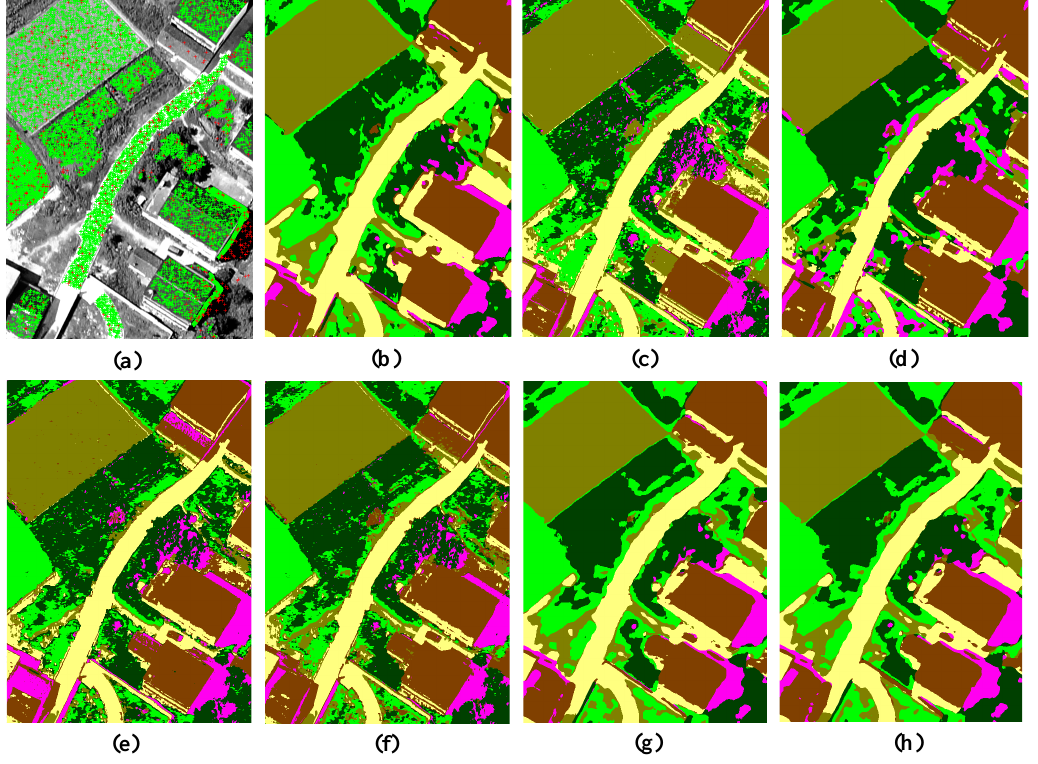
Figure 11. Classification results of the compared methods for JX_1 data: ( a ) Selected training samples (red markers are the initial selected training points, and the green markers are the final selected training points). ( b ) CNNs. ( c ) TSVM. ( d ) SemiMLR. ( e ) SemiSAE. ( f ) Ladder network. ( g ) Spectral-spatial view. ( h ) HMVSSL